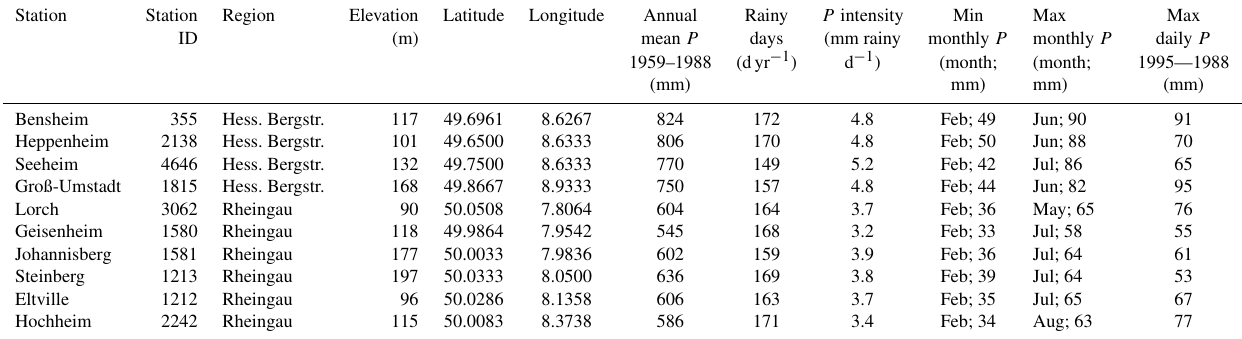
Table 1. Description and parameters for precipitation ( P ) of the weather stations used to calibrate the weather generator with data from 1959– 1988 and to analyse the drought stress occurrence of the past. Weather data were extracted from the database of the DWD (2018) and are available online at https://opendata.dwd.de (last access: 15 December 2018).